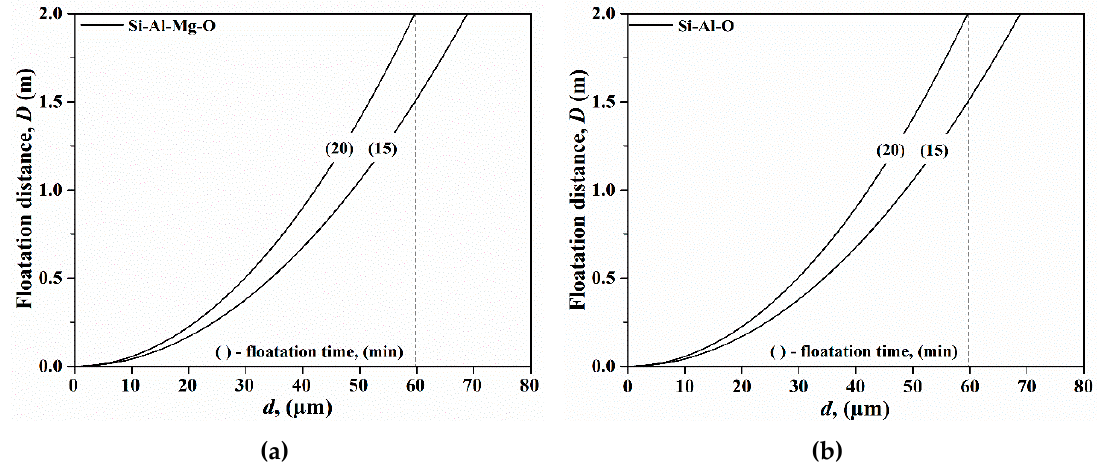
Figure 3. The floatation distances for Si-Al-Mg-O ( a ) and Si-Al-O ( b ) inclusions in liquid steel.